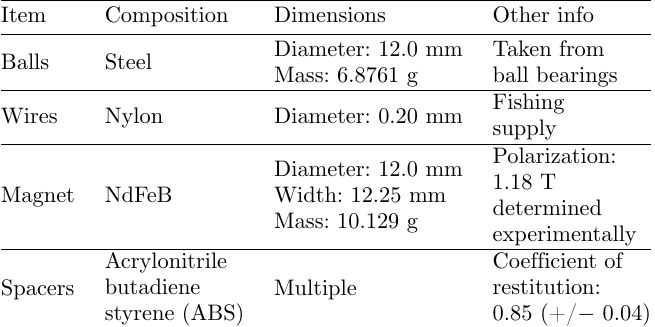
Table 1. Materials used to build the Gauss